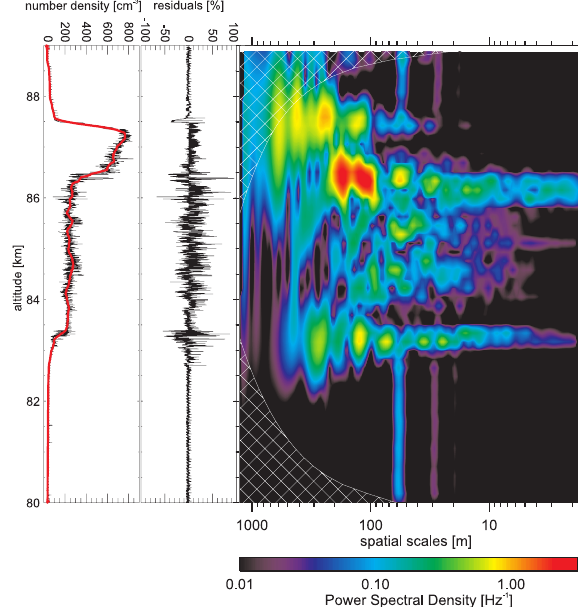
Fig. 4. In situ charged aerosol density measurements during ECOMA flight (ECOMA DC-channel). Left panel: particle density (black) and reference profile (red) used to derive residuals. Middle panel: relative density fluctuations of charged particles (residuals). Right panel: wavelet power spectrum of the residuals (derived using Morlet-12 wavelet